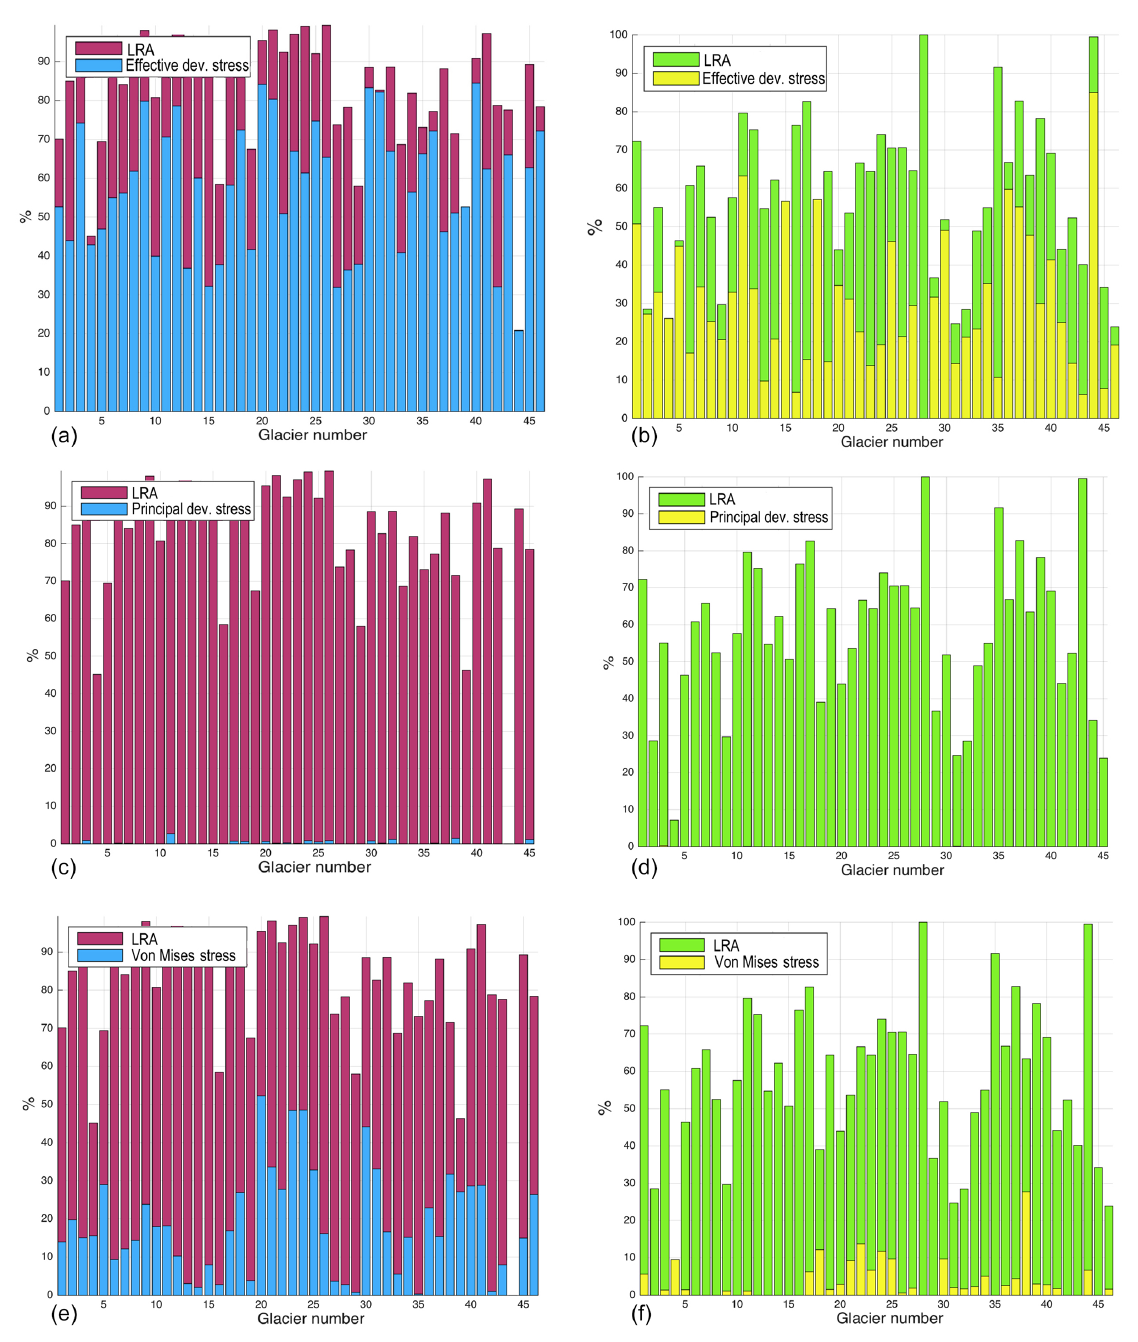
Figure 1. Comparison between the success of identifying fractures using LRA (purple for grounded ice, green for floating ice) and using test set 1: effective deviatoric stress (effective dev. stress); test set 2: principal deviatoric stress 1 and 2; and test set 3: von Mises stress (blue for grounded ice, yellow for floating ice). Left column represents grounded ice (a, c, e) , and right column show the results for floating ice (b, d, f)